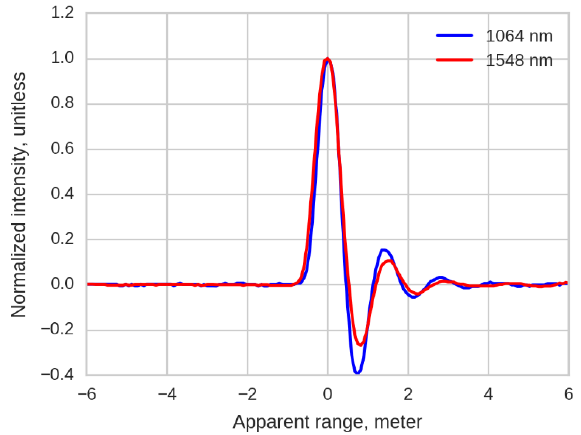
Figure 1. DWEL system response pulse. The two pulse peaks at the two wavelengths are aligned.